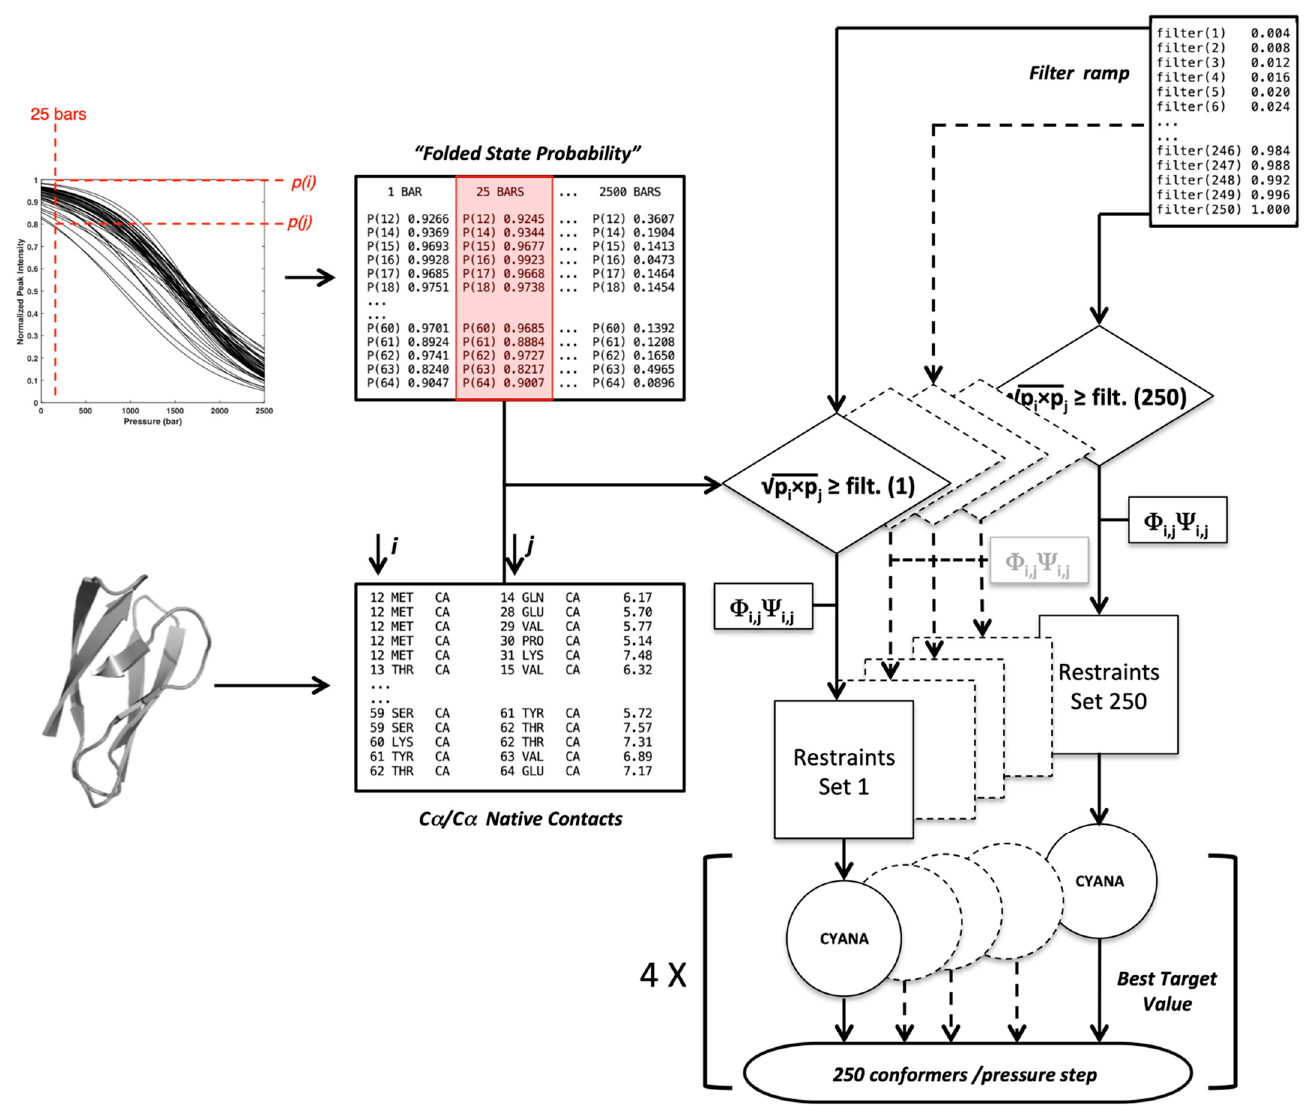
Figure 10. Flowchart used to generate the conformers present in the proteins folding landscape. The C α –C α contacts and the Φ / Ψ dihedral angles were measured from the native X-ray structures. For a given pressure, the folded state probabilities p i and p j were challenged against a filtering ramp to construct upper bound distance restraints’ files that were complemented by Φ i , j Ψ i , j dihedral restraints. Each of the 250 restraints sets was used as the input in Cyana3 .